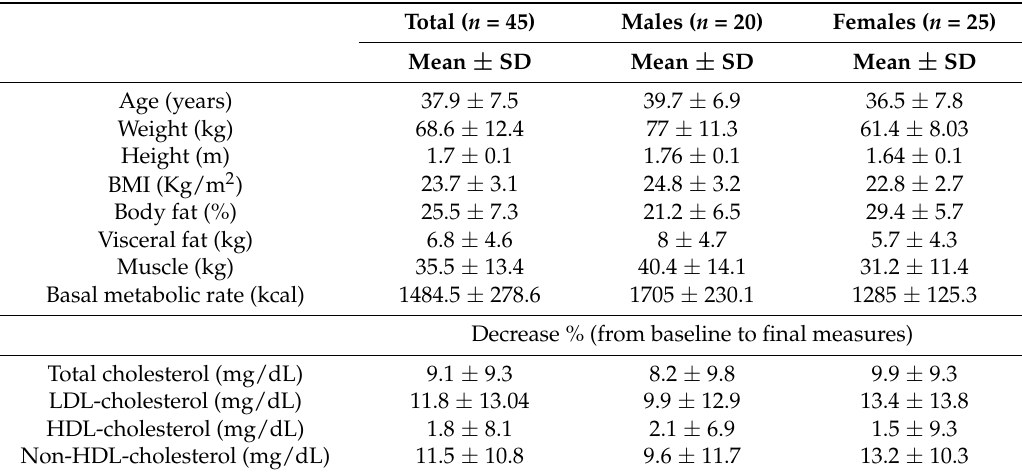
Table 1. Descriptive statistics of the anthropometric measurements and lipid